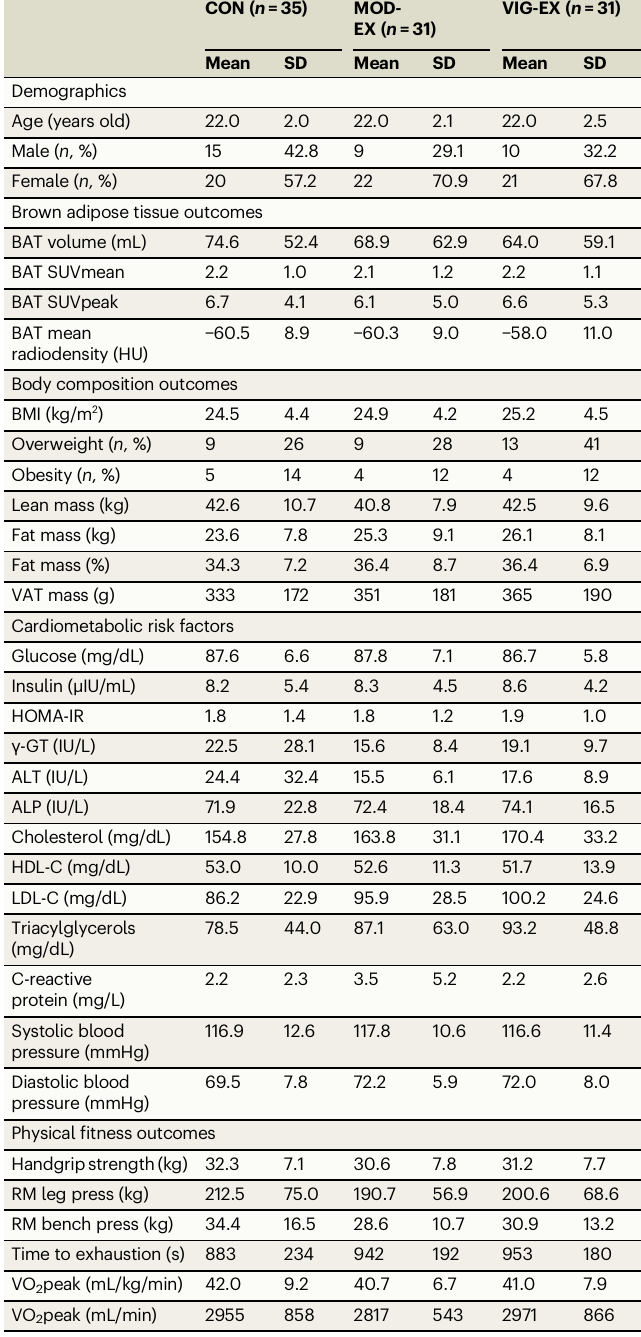
Table 1 | Baseline characteristics of the study